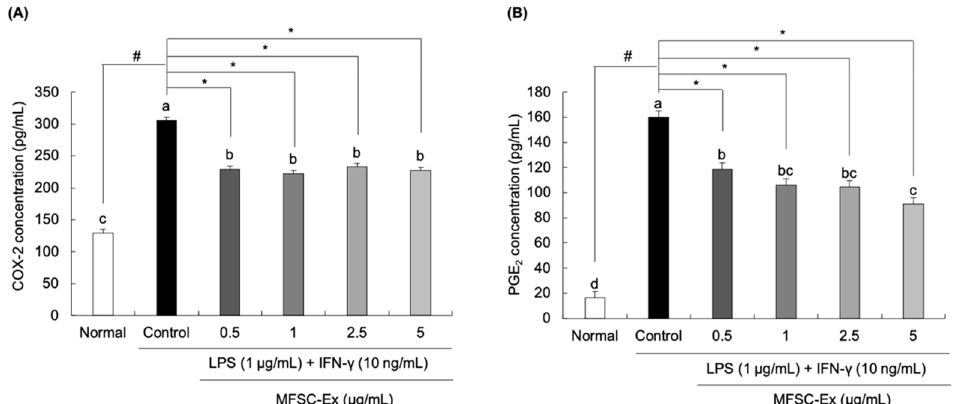
Figure 3. Effect of MFSC-Ex on COX-2 ( A ) and PGE 2 ( B ) production in LPS/IFN- γ -stimulated RAW 264.7 macrophage cells. Cells were treated with various concentrations of MFSC-Ex (0.5, 1, 2.5, 5 µ g/mL) for 2 h, followed by LPS (1 µ g/mL) and IFN- γ (10 ng/mL) for 24 h. Values are expressed as means ± SD. a–d Means with the different letters are significantly different ( p < 0.05) by Duncan’s multiple range test. # p < 0.05 vs. normal (un-treated) group, * p < 0.05 vs. control (LPS/IFN- γ -treated) group.